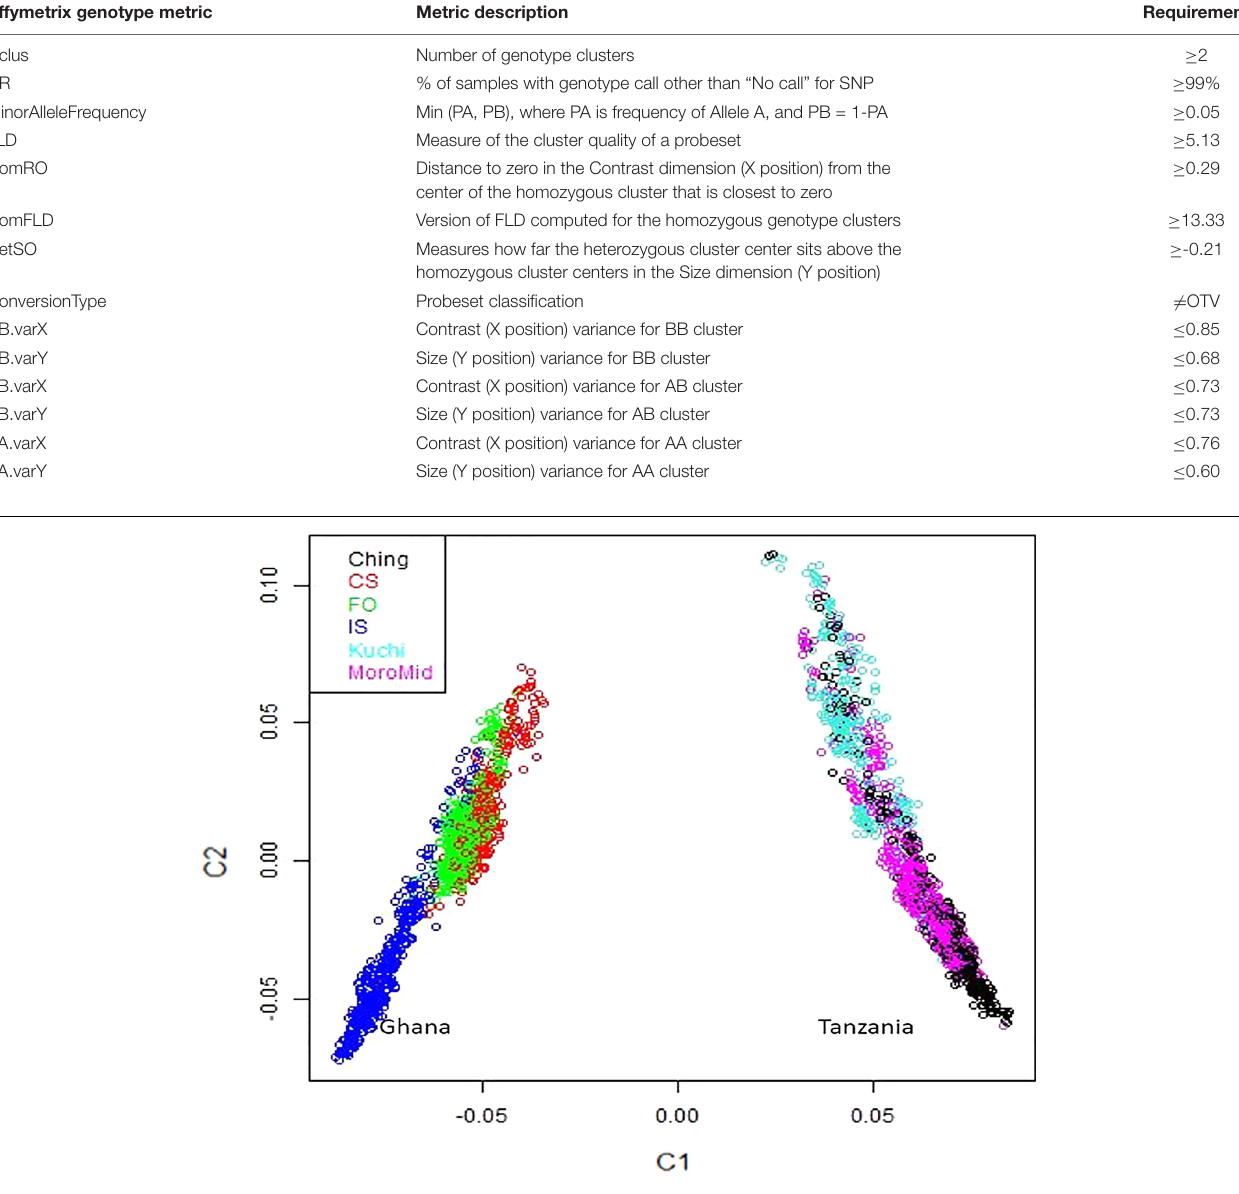
FIGURE 1 | Multi-dimensional scaling plot showing distinct separation between the Ghana and Tanzania